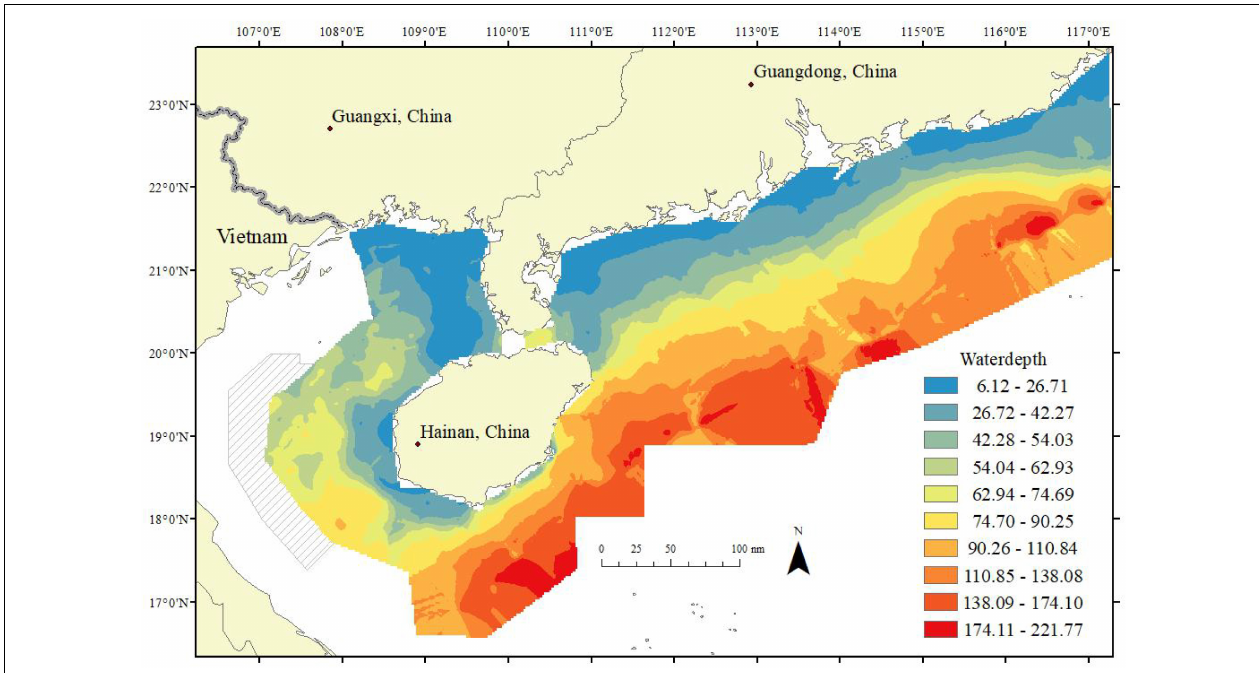
FIGURE 8 | The spatial distribution characteristics of water depth measured by acoustic equipment: blue is the shallowest, yellow is the middle, and red is the